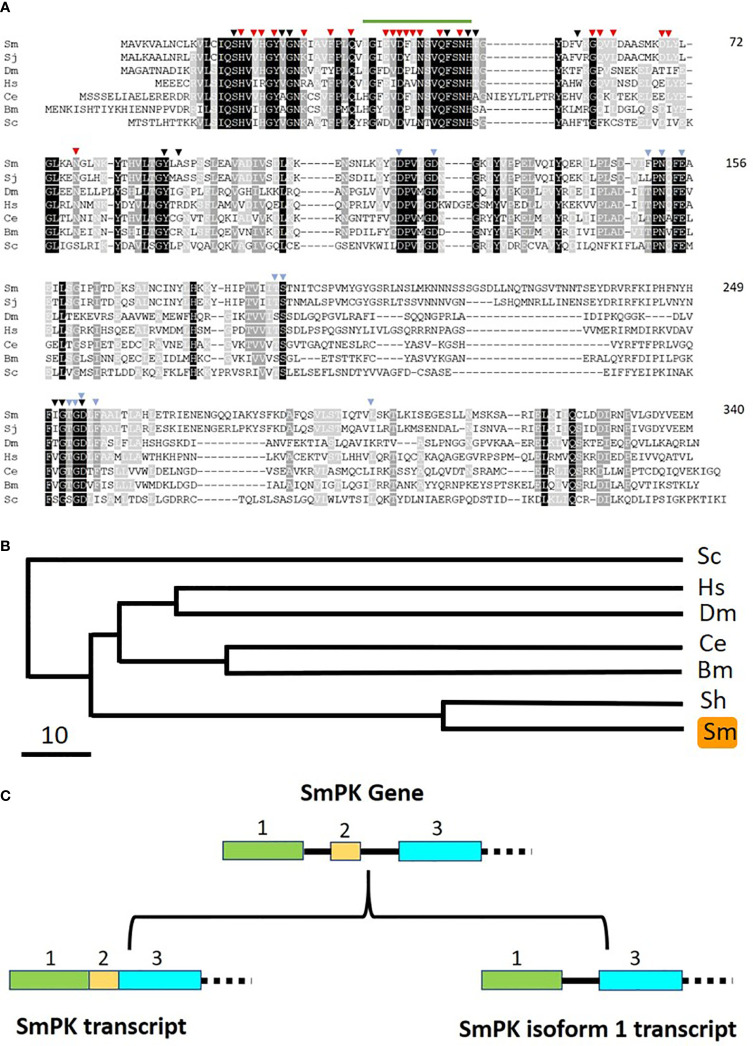
Alignment of SmPK with other members of the pyridoxal kinase protein family. Sm, Schistosoma mansoni (GeneBank accession number MW148599); Sj, Schistosoma japonicum (CAX69335.1); Hs, Homo sapiens (NP_003672); Dm, Drosophila melanogaster (AAR82765); Ce, Caenorhabditis elegans (NP_491463.2); Bm, Brugia malayi (VI094344); Sc, Saccharomyces cerevisiae (NP_014424). Residues found in all seven sequences are depicted as white on a black background; those common to six of the seven pyridoxal kinase homologs are white on a dark grey background and those found in a majority of the sequences (four or five out of seven) are white on a light grey background. Residues predicted to be involved in pyridoxal binding are indicated by black arrowheads; those involved in ATP binding by blue arrowheads and those involved in dimer formation, red arrowheads. The green line (top) indicates the sequence motif 36LGIEVDFINSVQFSNH51 that is replaced by 36CVLLIITY43 in the SmPK isoform 1 sequence reported in this work (GeneBank accession number of SmPK isoform 1: MW148600). Numbers at right are an amino acid count for the S. mansoni protein. (B) Phylogenetic tree (absolute distance) of selected pyridoxal kinases generated by multiple sequence alignment using UPGMA (unweighted pair group method with arithmetic mean). The designations (and accession numbers) of the homologs compared are as described in (A). (C) Depiction of the 5’end of the SmPK gene (top) and its spliced variants (bottom). In the upper panel, exons 1–3 of the SmPK gene are depicted as colored rectangles (and introns as black lines). In one transcript (lower left panel), both intron 1 and 2 are spliced out. Alternative splicing removes intron 1 and exon 2 but maintains intron 2 to generate the mature SmPK isoform 1 transcript. The dashed line signifies the remainder of the SmPK gene which is identical between transcripts.